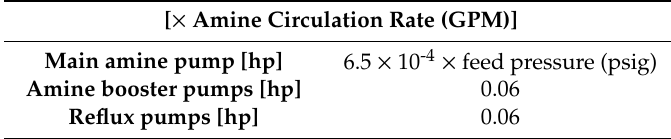
Table 6. Gas sweetening power requirement factor based on the amine circulation rate